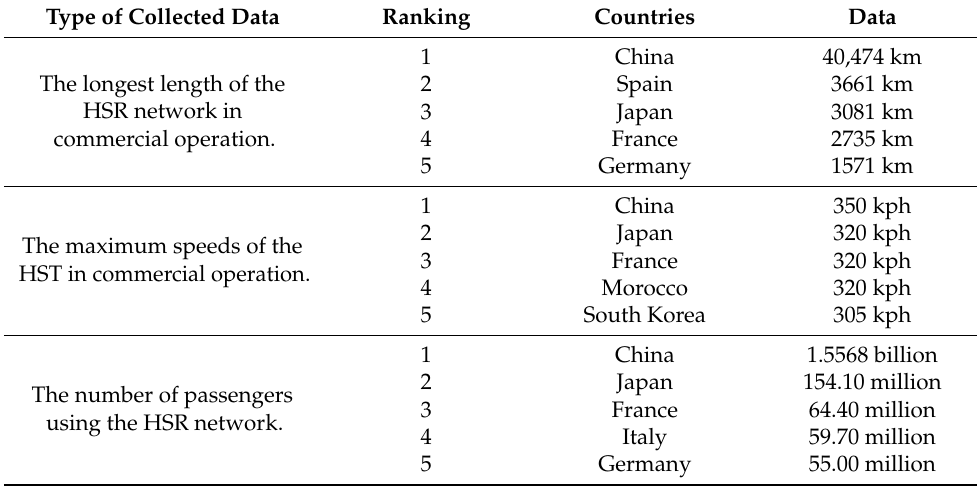
Table 1. Global HSR data 2022. Adapted from